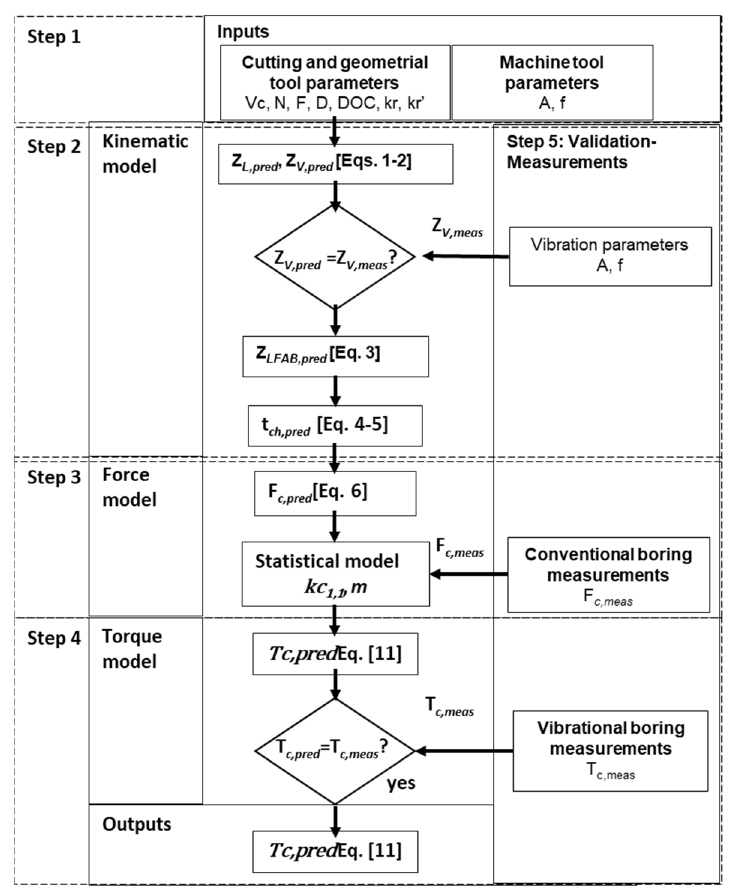
Figure 2. Flow chart of LFAB